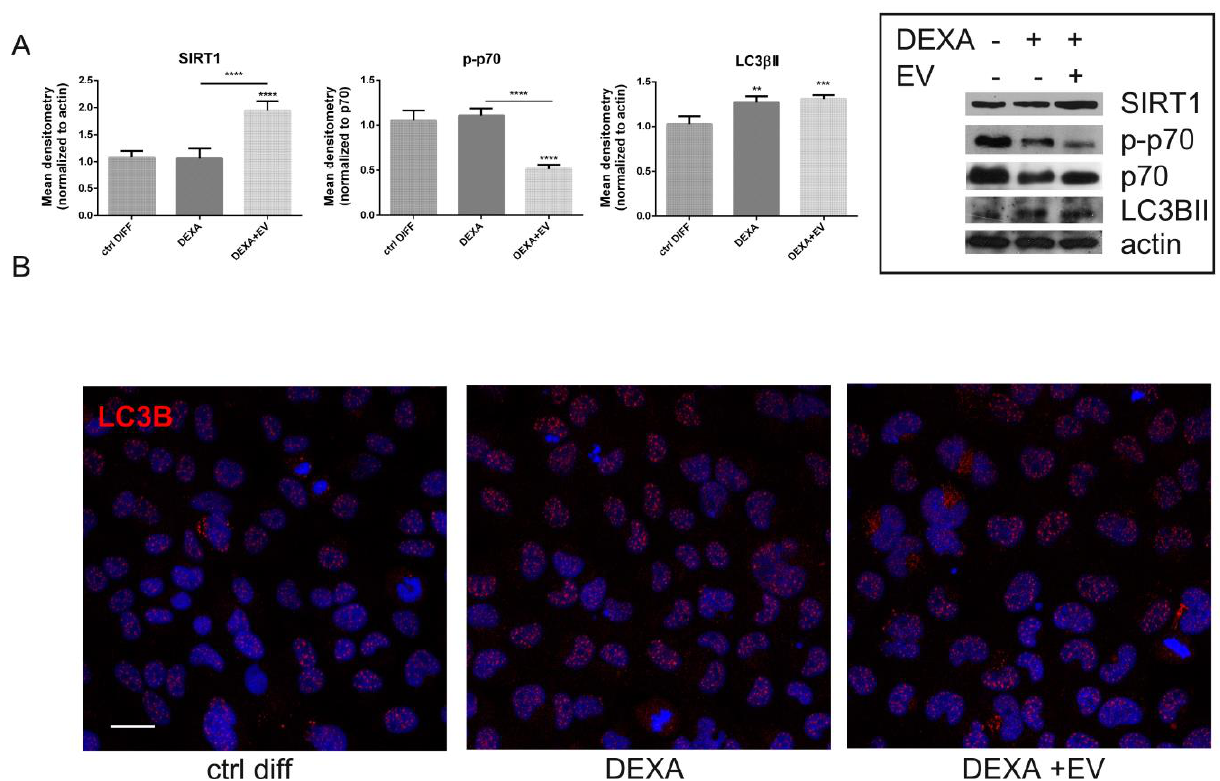
Figure 2. Effect of AFSC-EV supplementation on autophagic pathway of HOB treated or not with Dexamethasone. ( A )— Western blot analysis of total lysate of HOB cells treated or not with AFSC-EV in the presence of DEXA, then revealed with anti-SIRT1, anti-p-p70, anti-p70, and anti-LC3 β antibodies. The graphs represent the mean ± SD of densitometric analysis of three experiments, normalized to actin values. ** p value < 0.01; *** p value < 0.001; **** p value < 0.0001. ( B )—Representative images with DAPI (blue) and LC3 β (red) signals of HOB cells incubated or not with DEXA and EV are shown. Scale bar = 10 µ